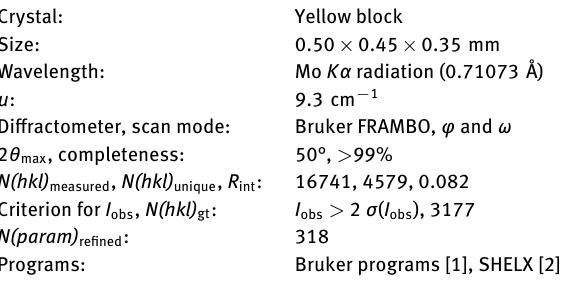
Table 1: Data collection and